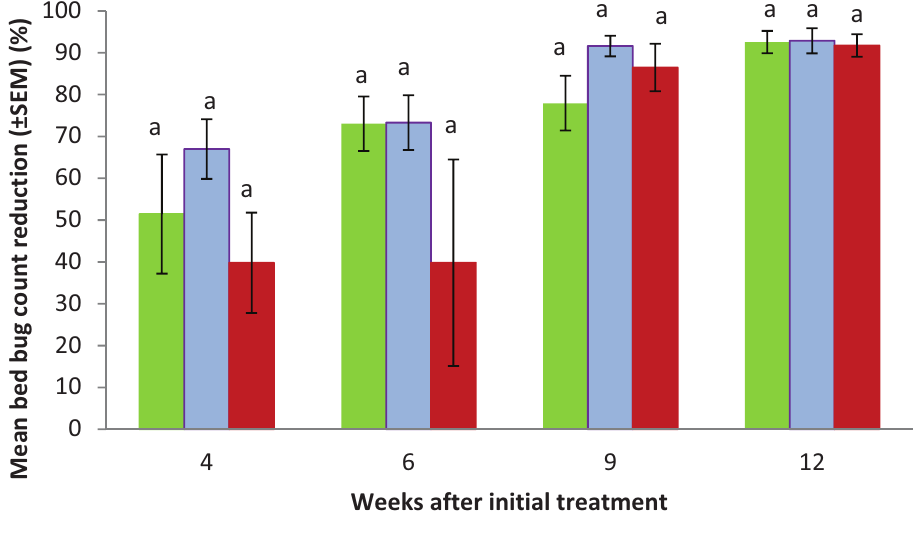
Figure 2. Effect of three treatments on bed bug count reduction. Means within the same observation period with same letters are statistically not different (ANOVA, p >